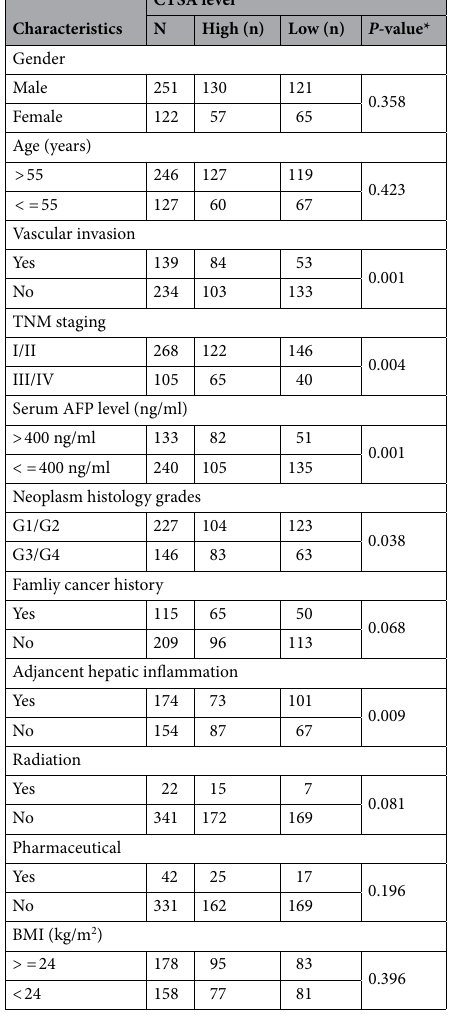
Table 1. Correlation between CTSA expression and clinical outcomes in HCC patients (373 cases, TCGA